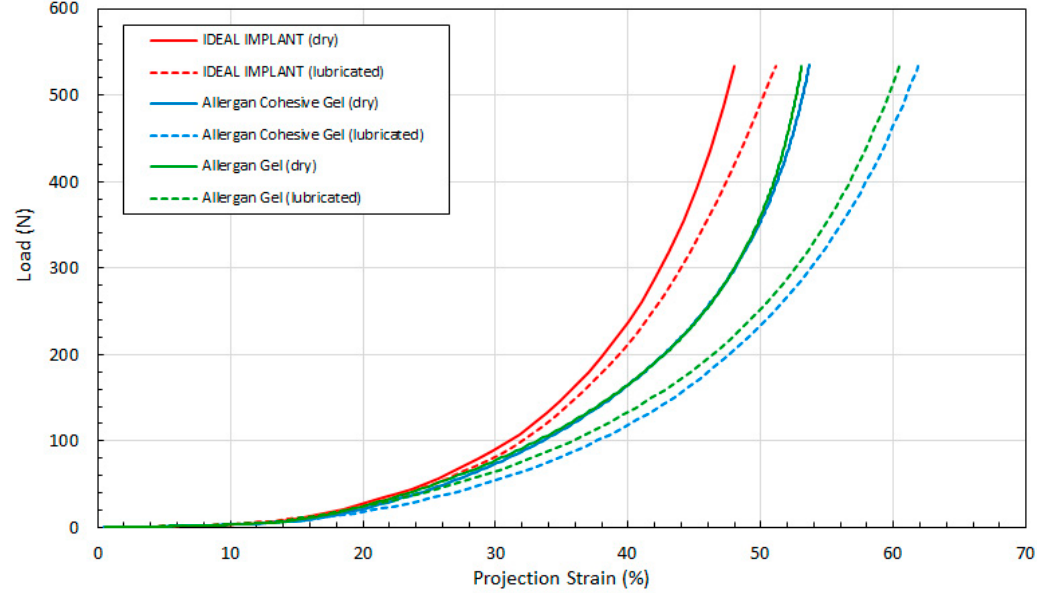
Figure 11. Load vs. Projection Strain, Dry and Lubricated Platens.